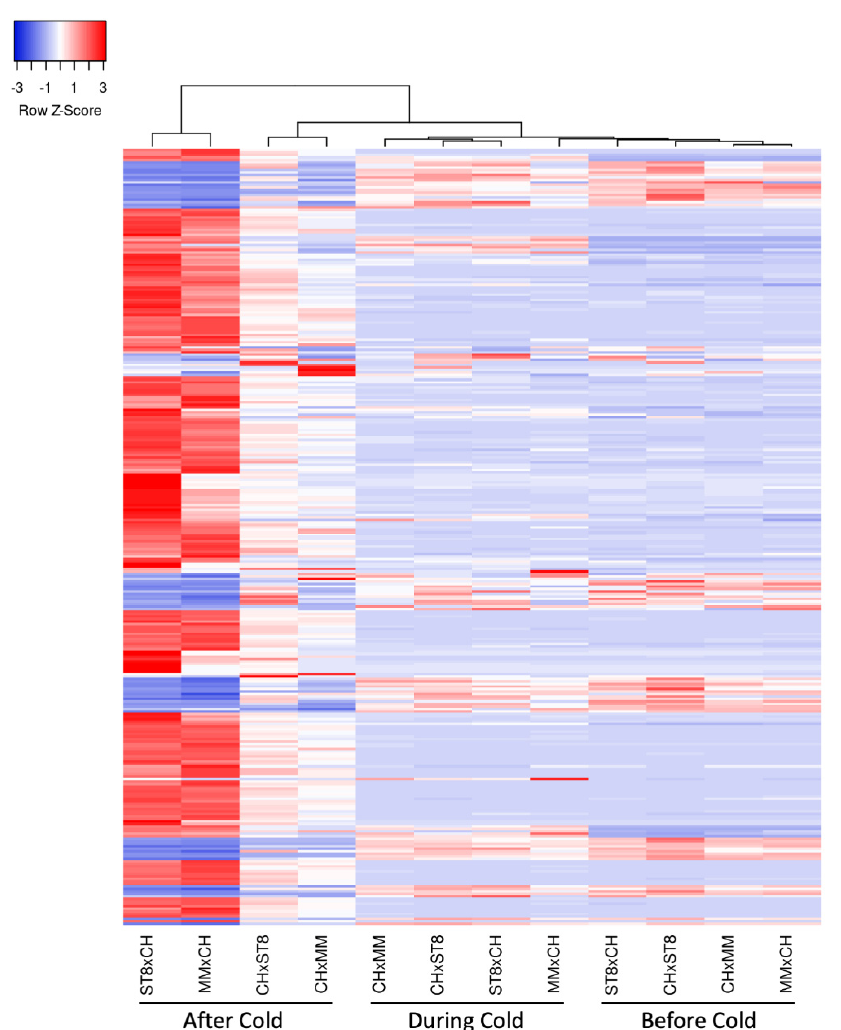
Figure 6. Heatmap of relative expression of significantly ( FDR < 0.05) differentially expressed genes (DEGs; rows) with a log2FC > 2 in at least one timepoint, colored by Z-score calculated for each gene across samples (columns). Genes and samples are clustered using average linkage method based on Euclidean distance. Hybrids (CHxMM, MMxCH, CHxST8, and ST8xCH) were grown in a greenhouse at 28 ◦ C for 10 days then cold treated at 4 ◦ C for 5.5 h at a light intensity of 270 µ mol · s − 1 · m − 2 . Samples were collected before cold treatment (Before Cold), at hour 3 during cold treatment (During Cold), or 1 day after onset of cold treatment (After Cold).